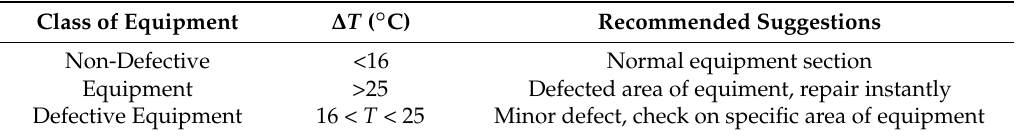
Table 1. Three categories of investigations with recommended